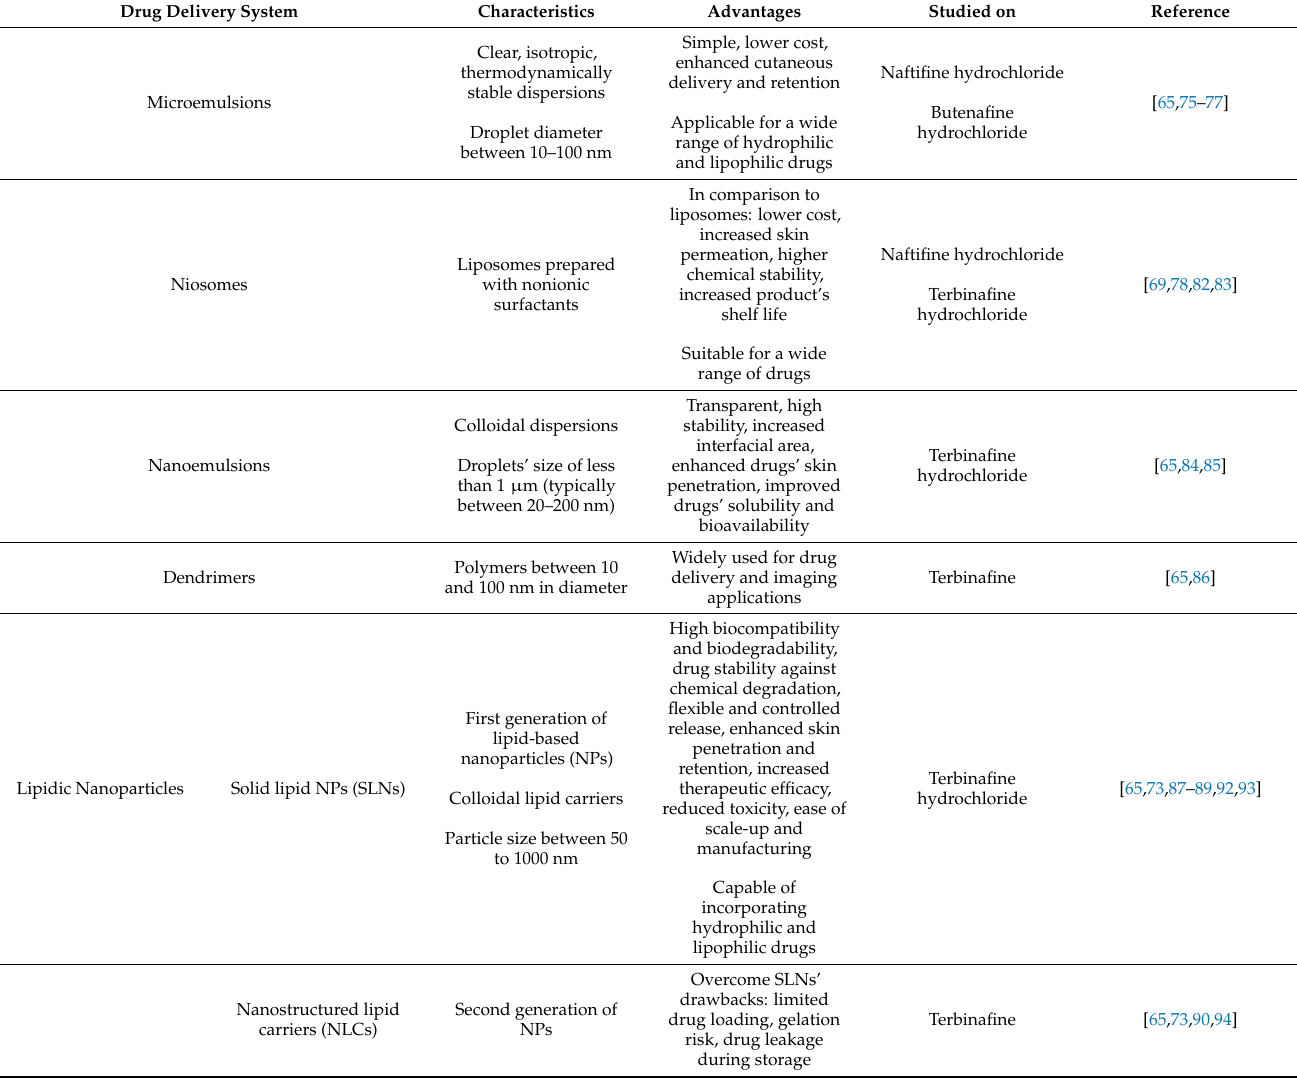
Table 2. Novel drug delivery systems of allylamines and